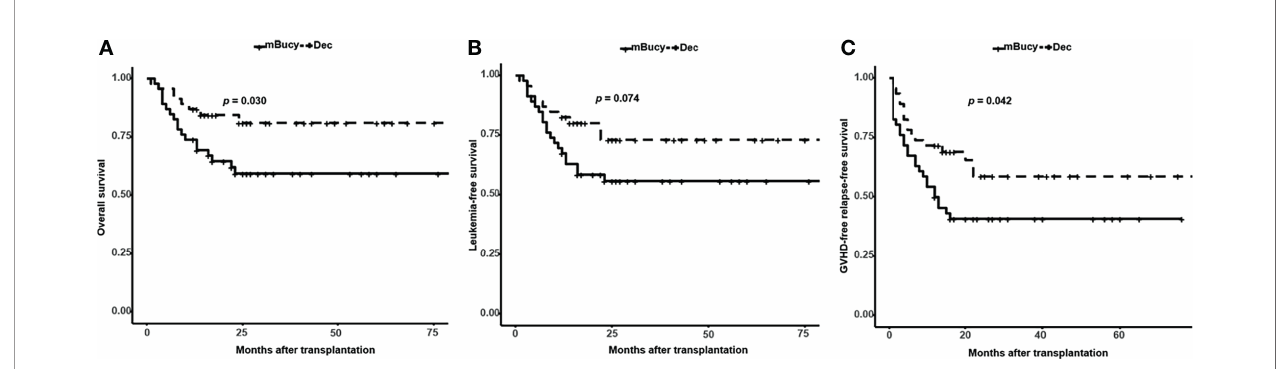
FIGURE 3 | Probability of (A) overall survival, (B) leukemia-free survival, and (C) graft-versus-host disease (GVHD)-free relapse-free survival in the decitabine (Dec) group and the modi fi ed busulfan/cyclophosphamide (mBuCy) group.